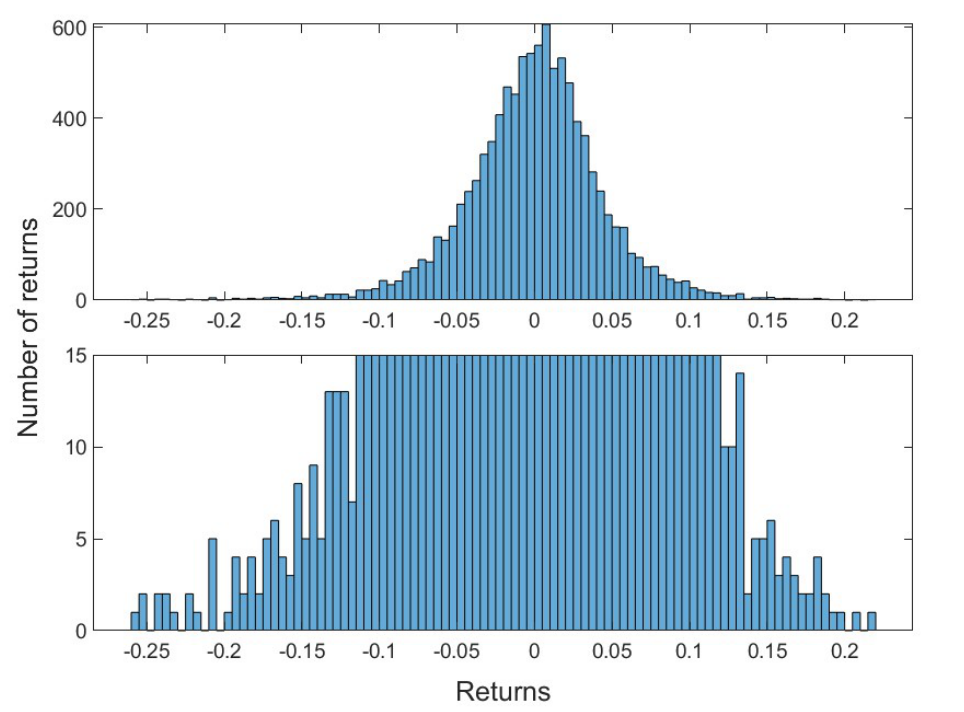
Figure 4. Histogram of the simulated daily portfolio